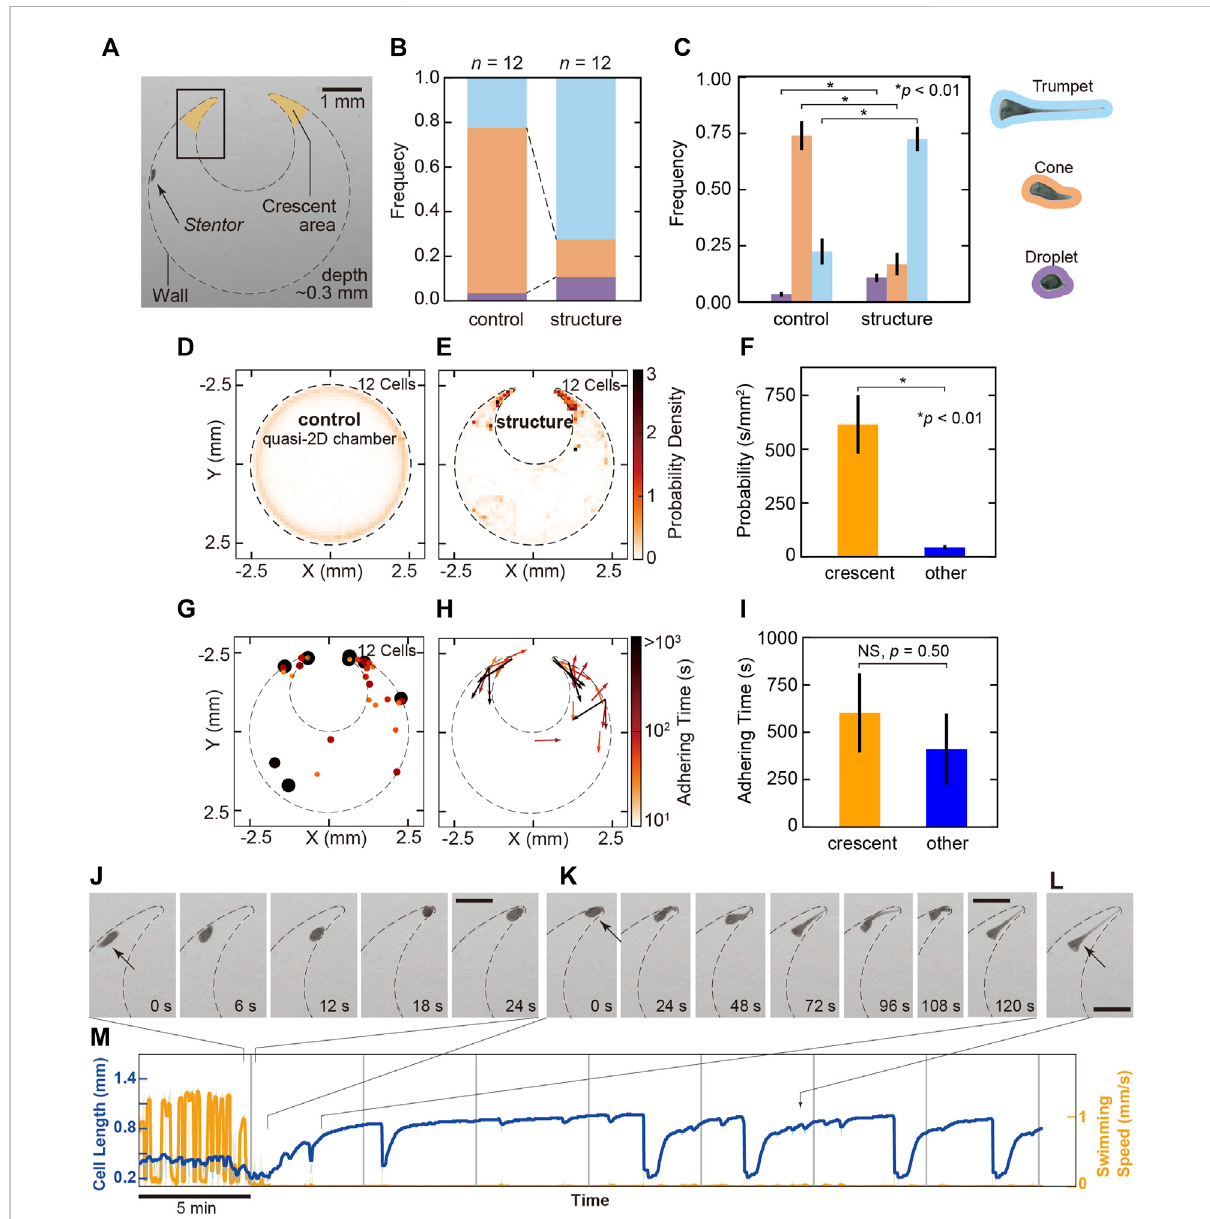
FIGURE 4 The behavioral change in swimming to adhesion in the crescent areas. (A) Image of the geometry of the gel chamber with the structure in the experiments. The dashed line represents the wall of the chamber. Crescent areas are indicated as two orange regions. The depth of the chamber is 0.3 mm. (B) The frequency of the cell states in the gel chamber with/without the structure. In the chamber without the structure (control), the cell mainlytakestheconestatein74.1%(orange),andtrumpet(lightblue)anddroplet(purple)statesareobservedin22.4%and3.5%,respectively.In the chamber with the structure, the cell mainly takes a trumpet shape in 72.4% and a droplet shape in 10.7%. Cone-shaped cells are observed in only 16.9% of cells. (C) The difference in the probability of three states in the simple chamber and in the chamber with structure. The colors correspond with each state indicated in (B) . This bar plot exhibits the probability of cell states in the simple chamber and the chamber with structure. The cone shape was dominant in the simple chambers, but the trumpet type was dominant in the chambers containing structures. The probability of the cell states was tested by Welch ’ s t -test, revealing signi fi cant differences between the chamber with/without structure ( p = 0.0026 in droplet; p = 6.3 × 10 − 7 in cone; p = 2.0 × 10 − 6 in trumpet). The bars are standard errors (12 cells). (D,E) 2D maps of the probability density observed in the cells in each chamber. (F) The comparison of presence probability within the crescent areas and other regions. Except for adhering, presence probabilities are 614.9 ± 136.6 s/mm 2 (SE, n = 12, 12 cells) in crescent and 43.4 ± 11.1 s/mm 2 (SE, n = 12, 12 cells) in other regions. The difference is statistically signi fi cant inWelch ’ s t -test.Black barsarestandard errors. (G) Thelocations andduration timesofadhesioninthecell.Thecolorand sizeofthedots represent the duration of the adhesion. The color bar represents the logarithmic adherence time scale. (H) The directions of the cell in the adhesive state. The color and length of the vectors represent the adhering time in one direction. (I) The comparison of adhering time prior to the detachment within the crescent areas and other regions. Ten cells adhered in crescent areas (18 events) and 7 cells adhered in other regions (13 events)